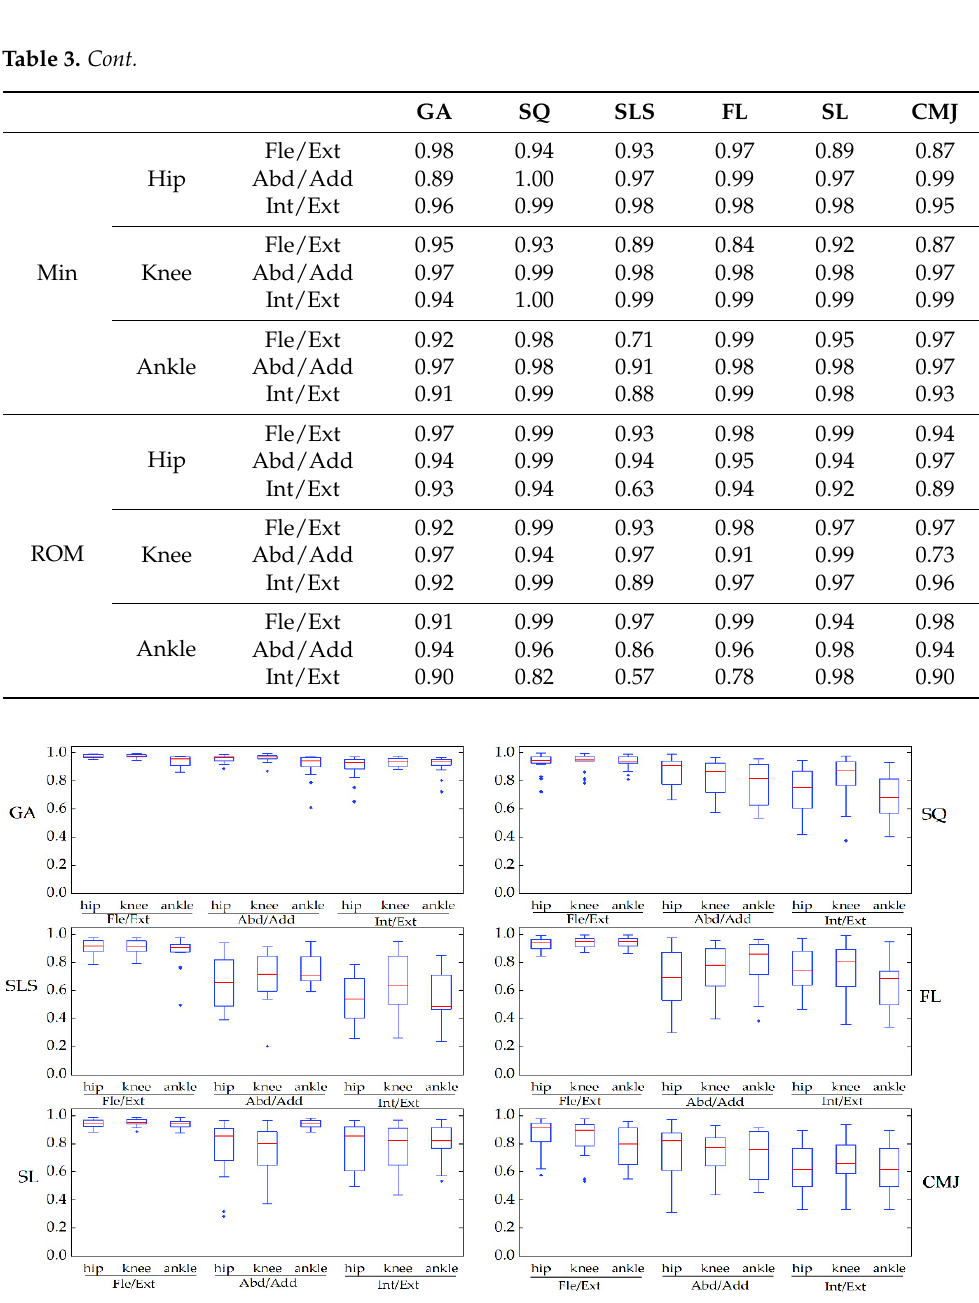
Figure 8. The waveform similarity in the Perception Neuron ® system between two days was examined using box-and-whiskers plots of CMC values in the gait (GA), squat (SQ), single-leg squat (SLS), side lunge (SL), forward lunge (FL), and counter-movement jump (CMJ). Fle/Ext stands for “Flexion/Extension”, Abd/Add for “Abduction/Adduction”, and Int/Ext for “Internal/External Ro- tation”. Table 2. The RMSE of IMU and OptiTrack systems collected in all tasks.